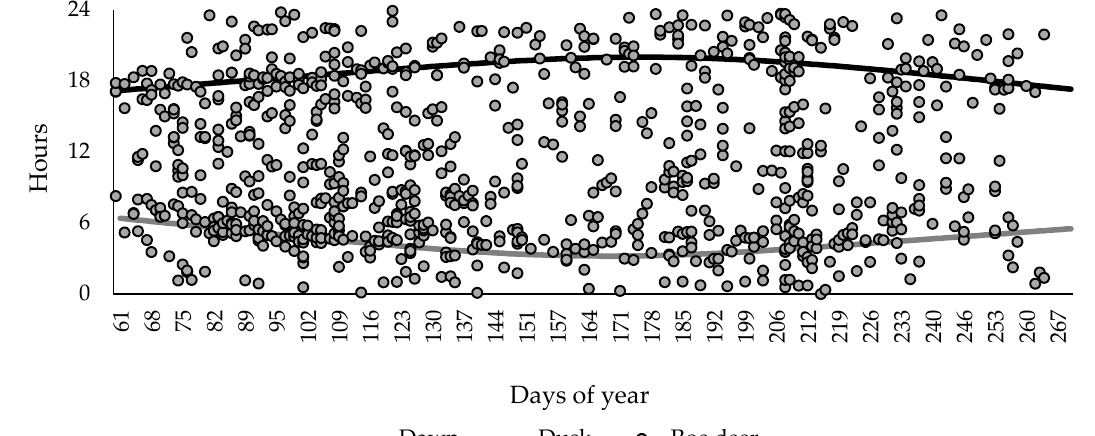
Figure 3. Temporal pattern of roe deer activity in a reproductive period (March–August) in urban forests of Warsaw in the years 2019–2020. Each dot refers to one case of roe deer presence recoded by a camera trap.